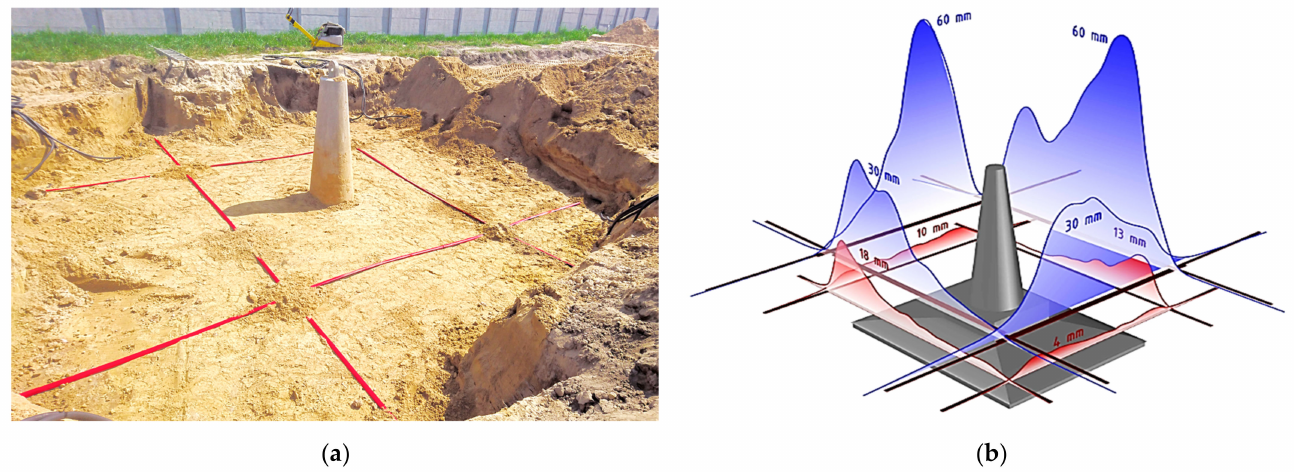
Figure 28. Geotechnical research field: ( a ) view of installed 3DSensor around the footing [46]; ( b ) spatial visualization of displacements profile calculated for a given load step during pulling the footing out of the ground [46].